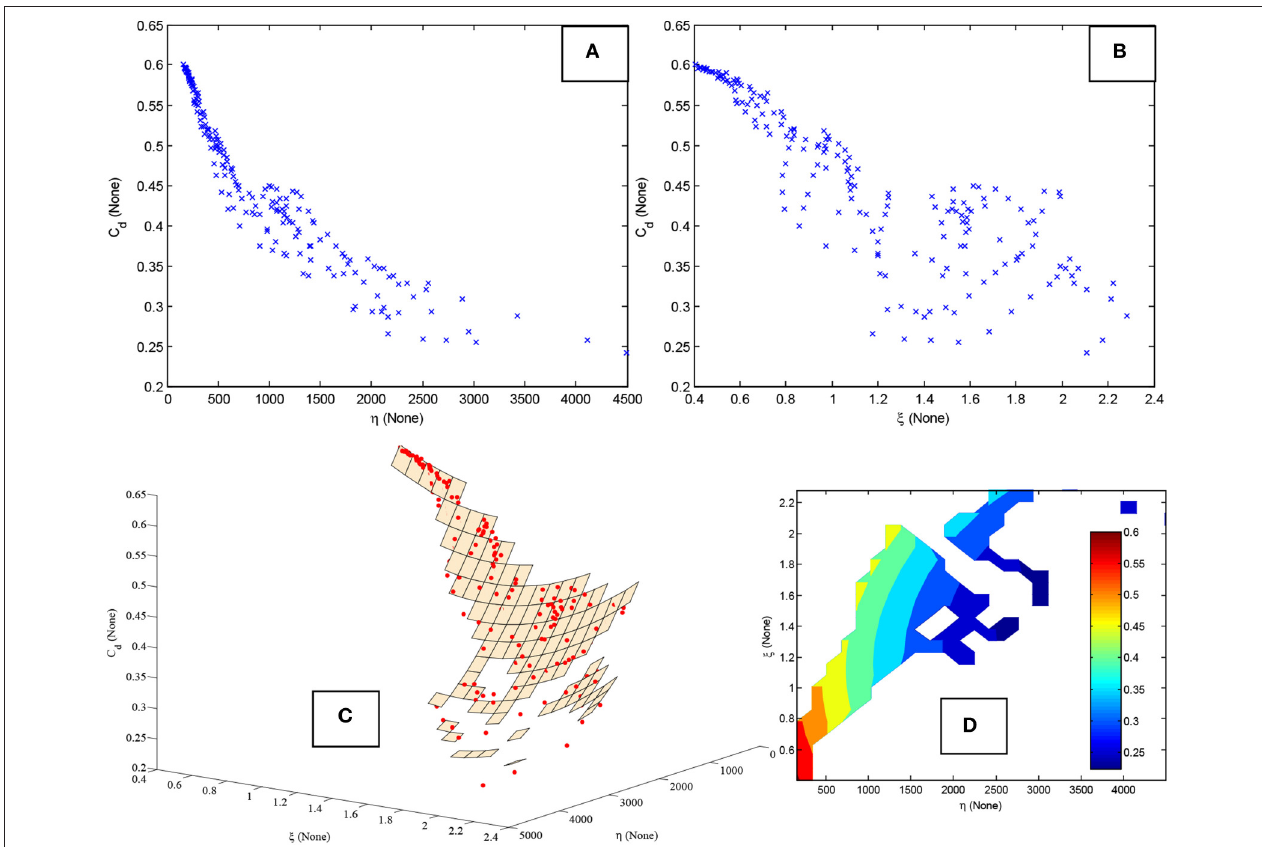
FIGURE 5 | (A,B) Discharge Coefficient plotted against dimensionless variables η and ξ . The variation of C d at any η is explained by ξ . (C) The C d data shown by the ξ surface generated by a linear regression model. (D) The contour plot further illustrates the non-linear response surface. red dots lie on a quadratic η −